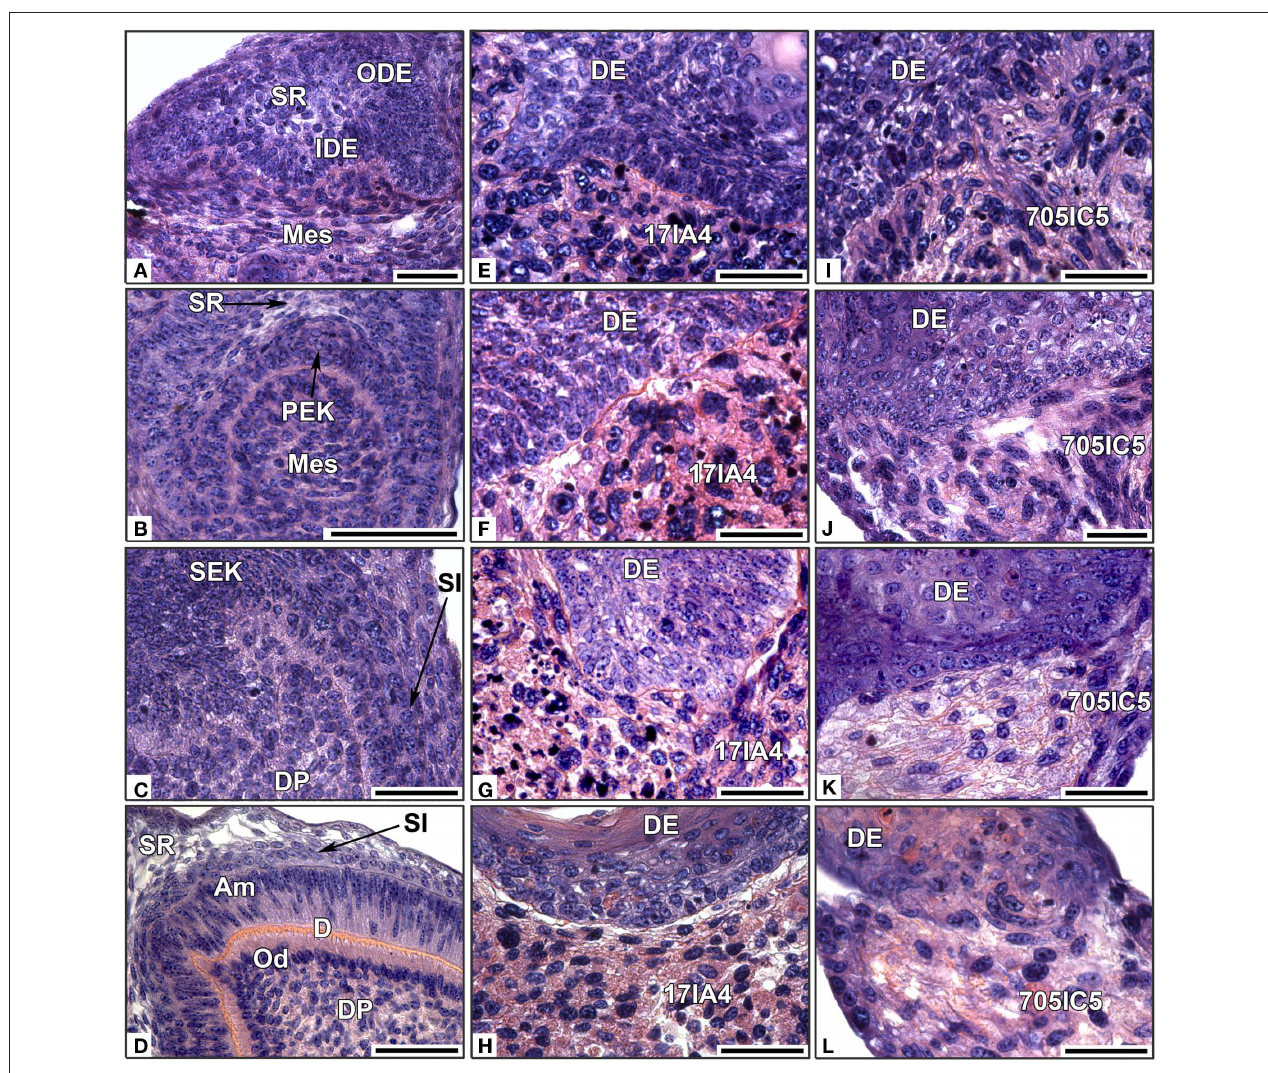
(A,e,i) , 4 days, (B,F,J) , 6 days (C,G,K) , or 10 days (D,H,L) . DE, dental epithelium; DP, dental papilla; IDE, inner dental epithelium; Mes, mesenchyme; ODE, outer dental epithelium; PEK, primary enamel knot; SEK, secondary enamel knot; SI, stratum intermedium; SR, stellate reticulum; Od, odontoblast; PAm, preameloblast. Bars = 40